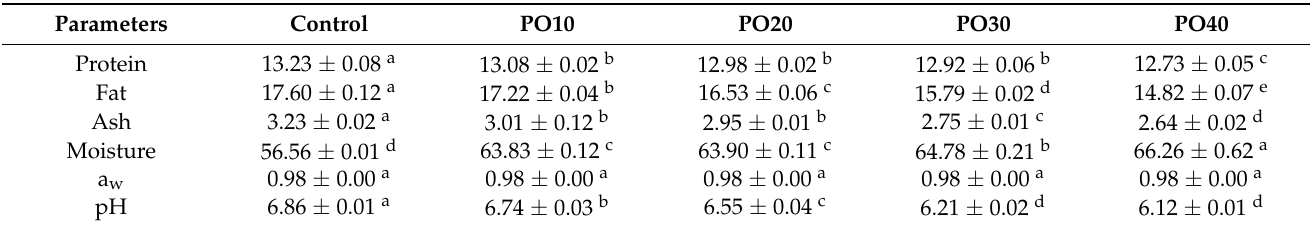
Table 2. Proximate composition (%), water activity, and pH of Pleurotus ostreatus (PO) pork sausages.